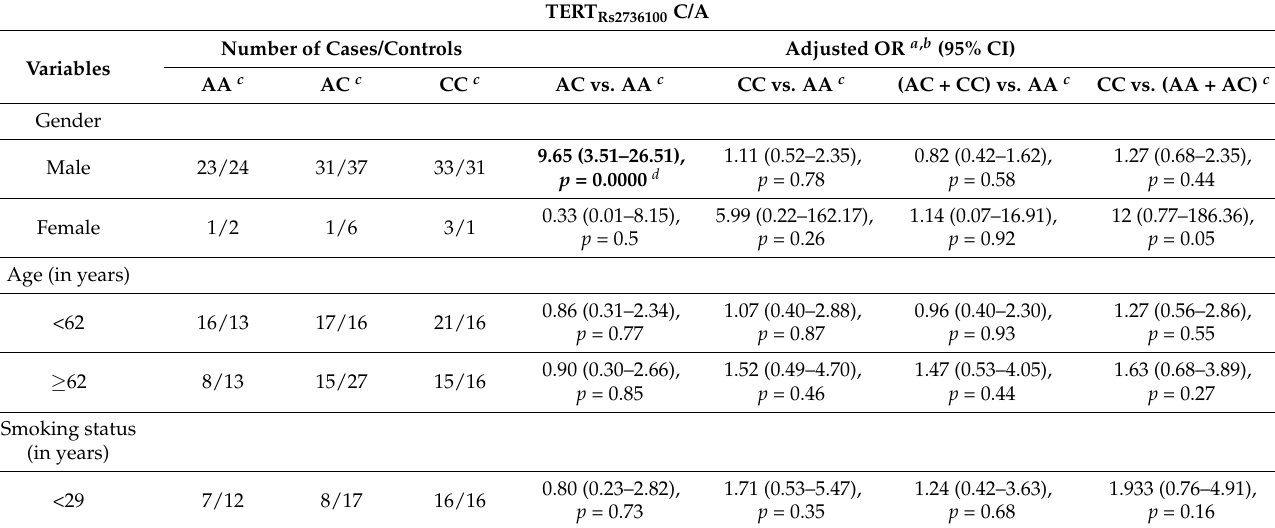
Table 5. Stratification analysis of the association between TERT Rs2736100 and laryngeal cancer. TERT Rs2736100